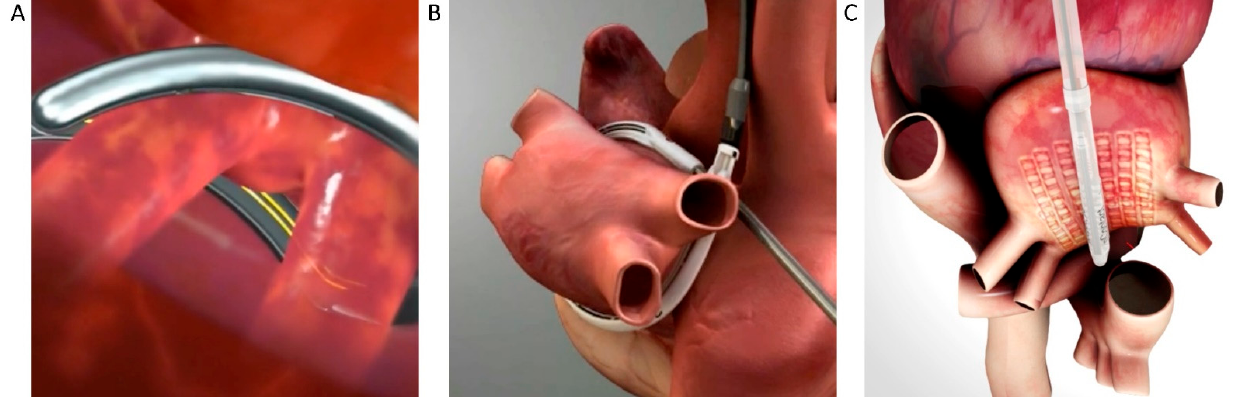
Figure 1. Videothoracoscopic Surgical Techniques overview. Panel ( A ): clamp technique; Panel ( B ): fusion technique; Panel ( C ): convergent technique.